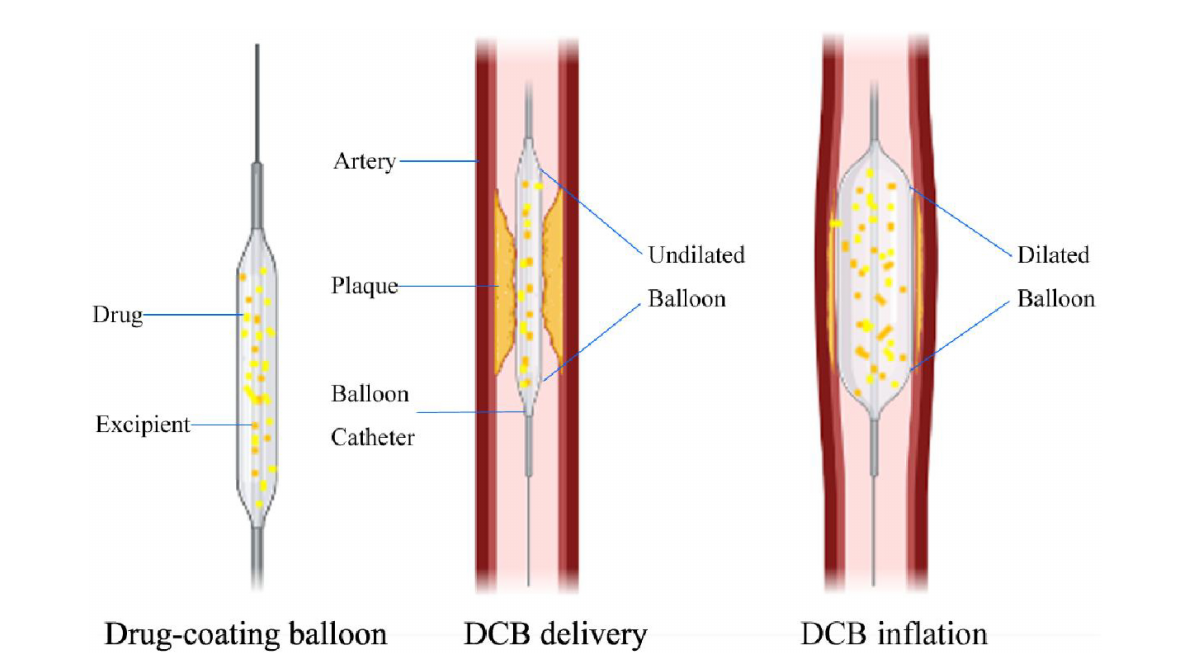
FIGURE1 Mechanisms of DCB in longitudinal section view. The difference between DCB and plain old balloon angioplasty (POBA) is that the balloon surface is coated with antiproliferative drugs and excipients. When the DCB reaches the lesion, as the balloon expands, the antiproliferative drug on the balloon surface can be transferred to the vessel wall, and the average expansion time is 30 –60